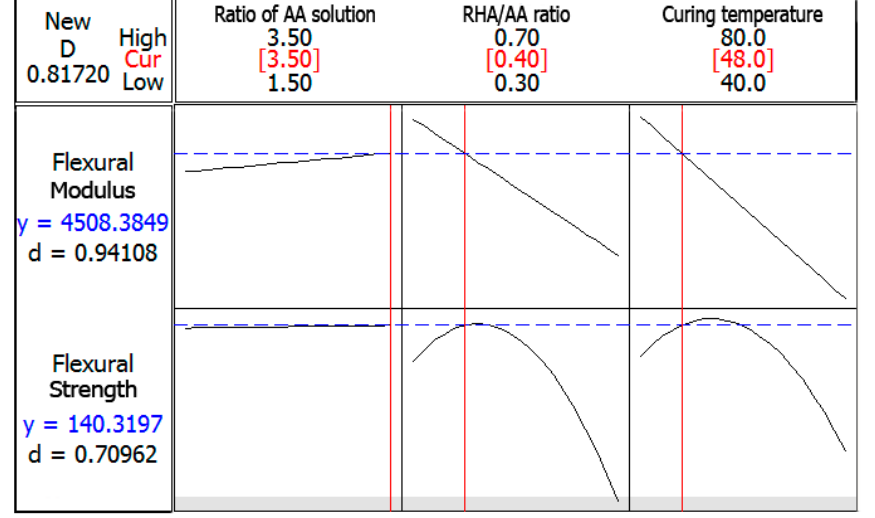
Figure 9. Optimization plot for maximum responses for flexural modulus and flexural strength.